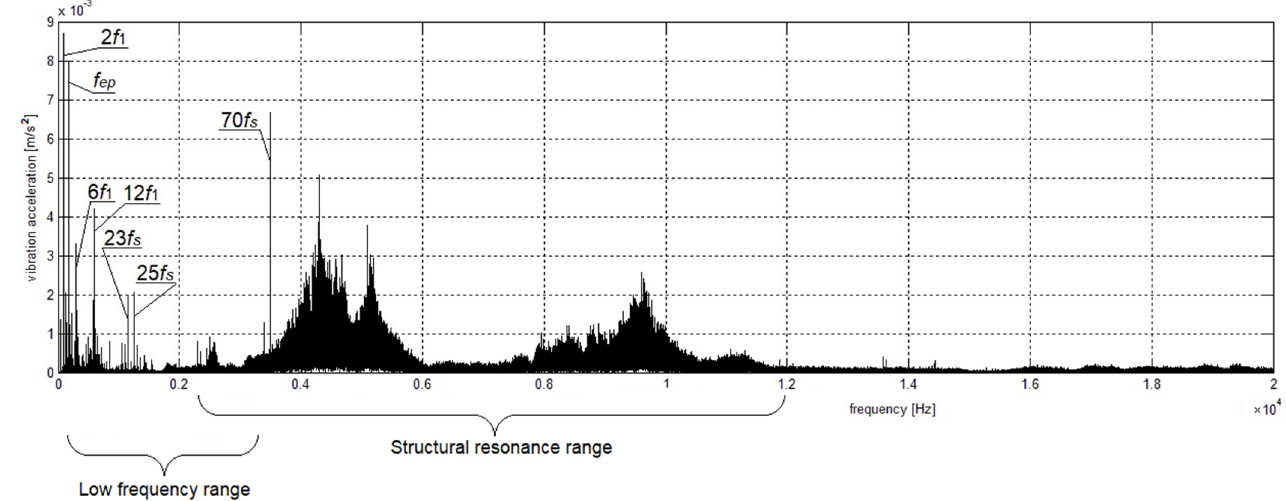
Figure 11. Frequency spectrum of vibration acceleration of the outer casing of the motor with a bearing slackness. The dominant frequency components of vibrations are marked.